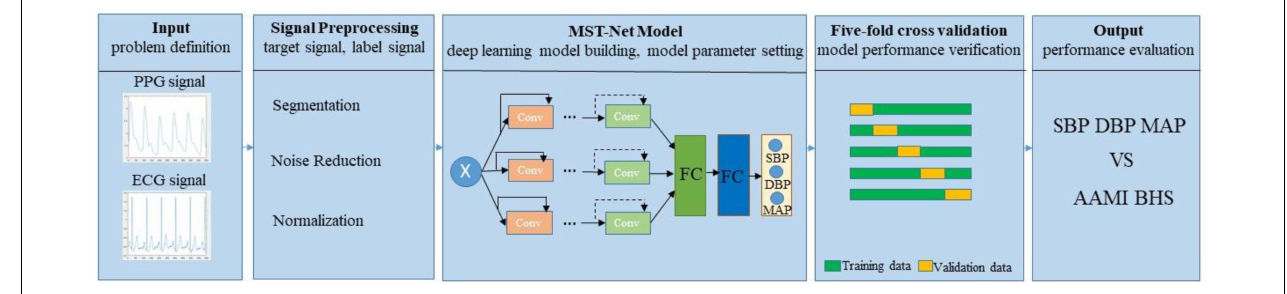
FIGURE 1 | Block diagram of the proposed continuous BP estimation